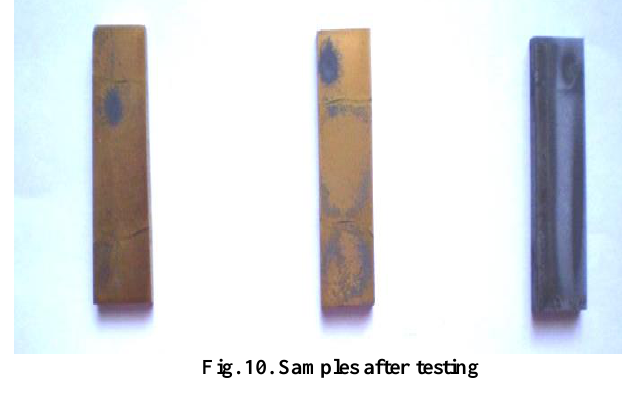
Fig. 10. Samples after testing